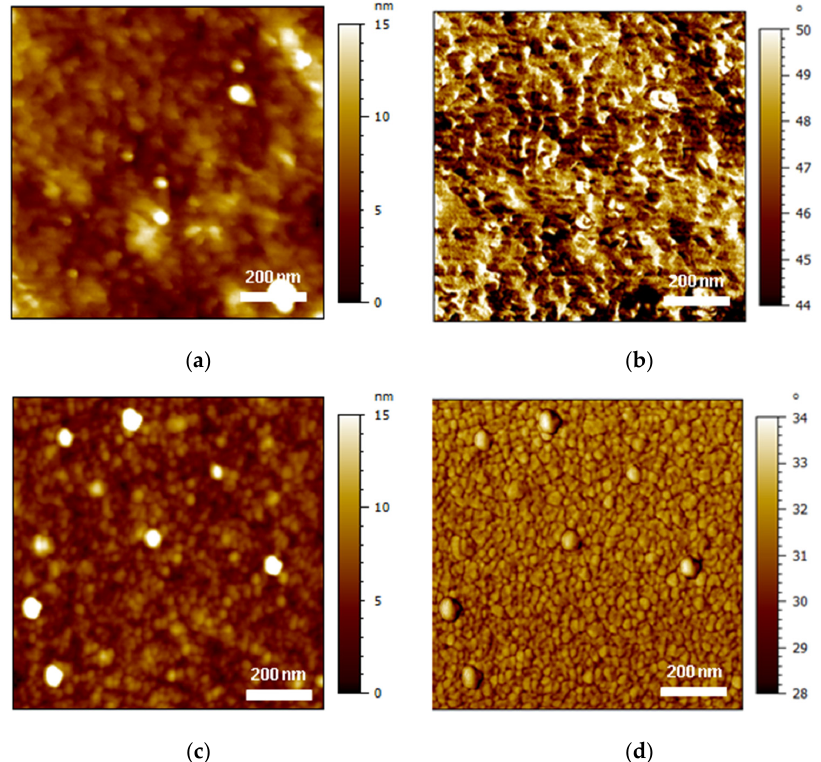
Figure 5. AFM images of PI film topography ( a ) and phase ( b ) on bare PI, as well as topography ( c ) and phase ( d ) after PDA coating.